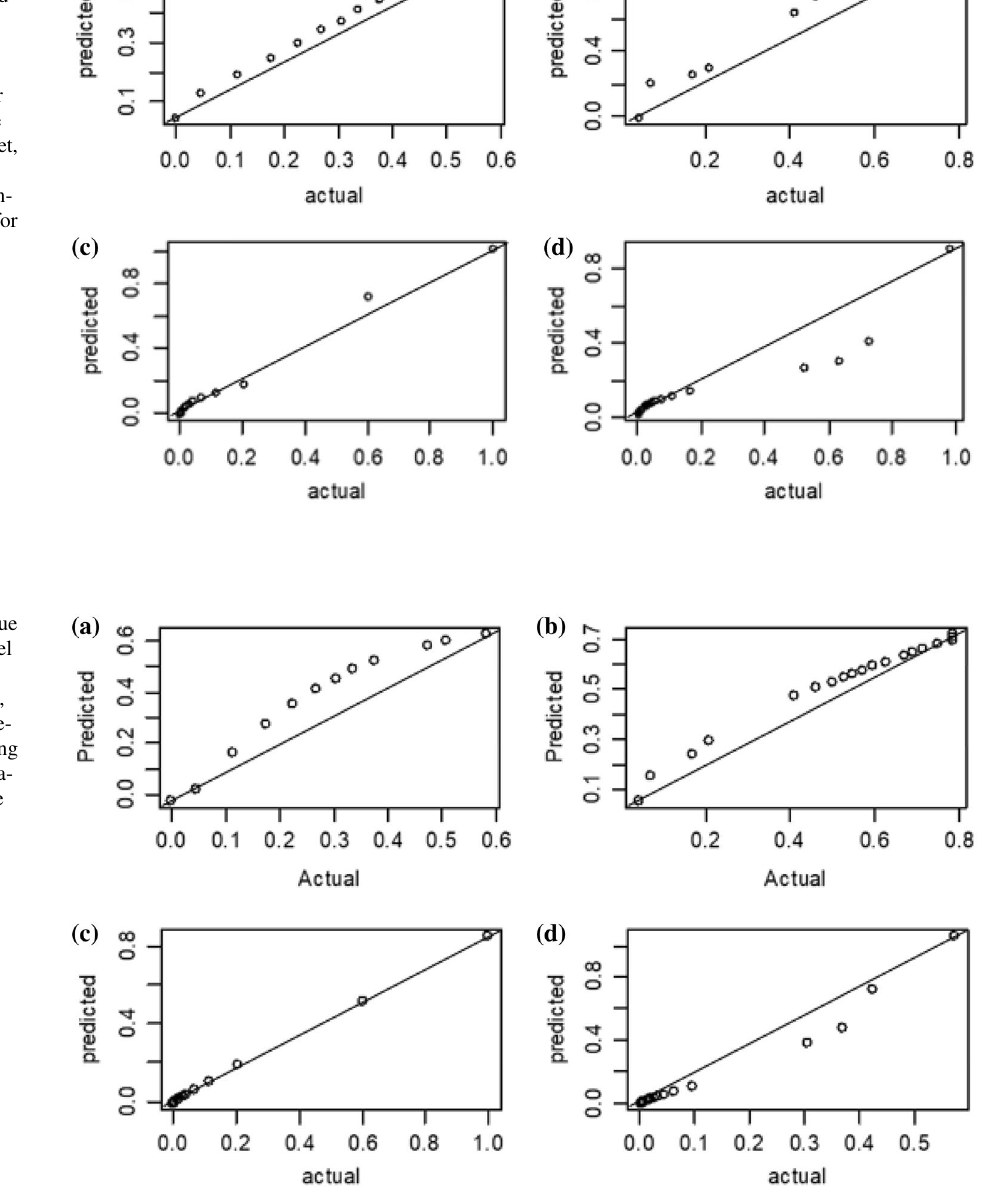
Fig. 5 Actual vs predicted value for neural networks with cross validation technique used for its model formulation and it improved prediction ability of the network with a wetting phase relative permeability for validation set, b wetting phase relative permeability for test set, c non-wetting relative perme- ability for validation set, d non- wetting relative permeability for the test set